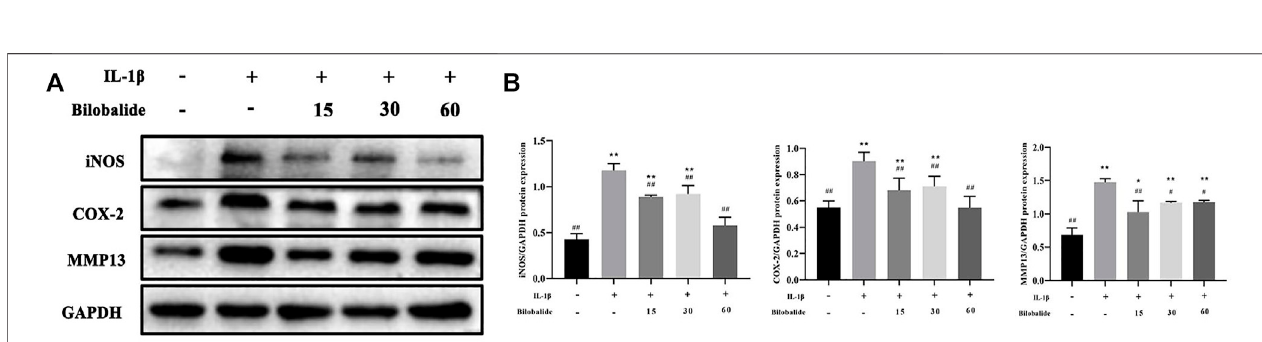
FIGURE 2 | In fl uence of bilobalide on the IL-1 β -induced in fl ammatory reaction in ATDC5 chondrocytes. (A,B) Western blot analysis of iNOS, COX-2, and MMP13 protein levels in chondrocytes. All data were presented asmean ± SD ( n = 3). * p < .05 and ** p < .01 compared to the control group; # p < .05 and ## p < .01 compared to the IL-1 β group (Statistical analysis using one-way ANOVA and paired two-tailed Student ’ s